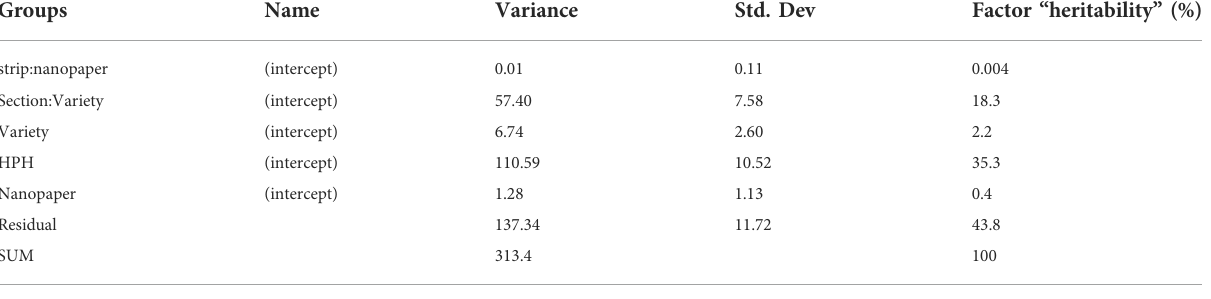
TABLE 2 Partitioning of factor variance for the Biomass-to-Nanopaper random effects model for the response variable of nanopaper tensile index. Groups